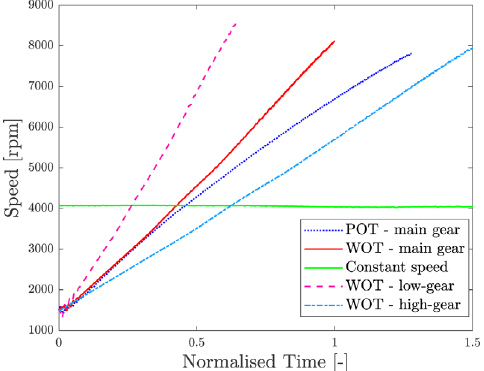
Figure 4. Comparison of the engine speed time histories of the analysed manoeuvres.